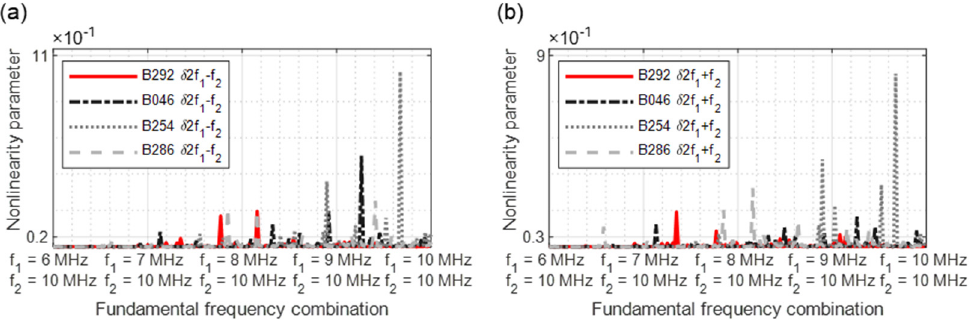
Figure 31. Nonlinearity parameter: ( a ) δ 2f 1 − f 2 ; ( b ) δ 2f 1 +f 2 .